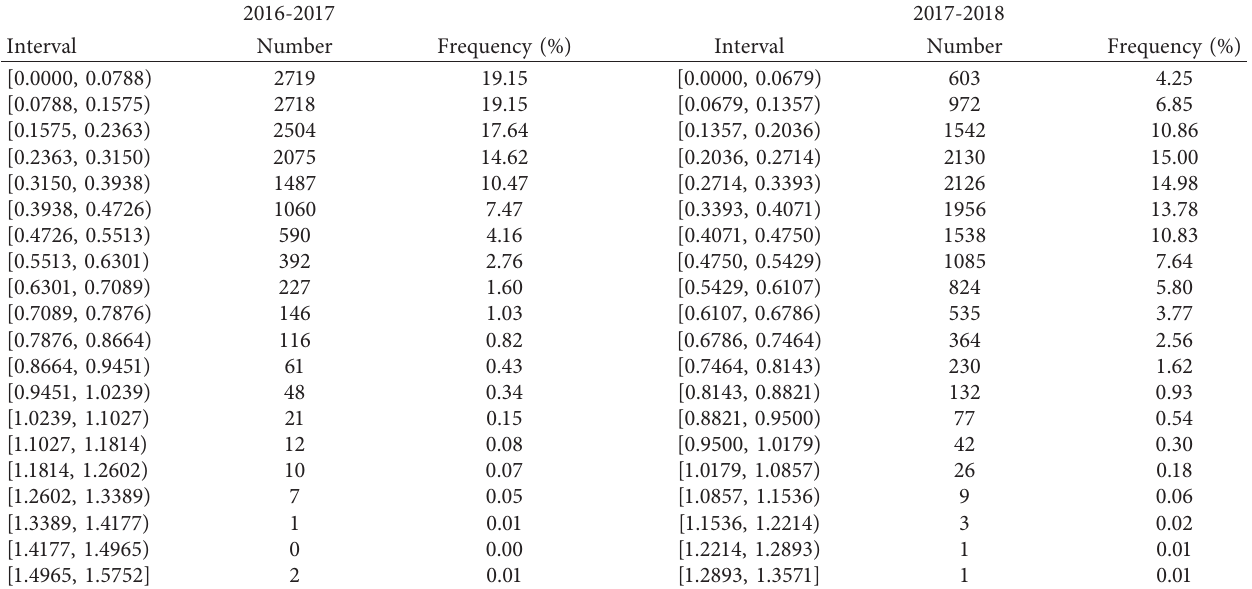
Table 4: Statistical chart of the absolute value of the cointegration coefficient during 2016-2017 and